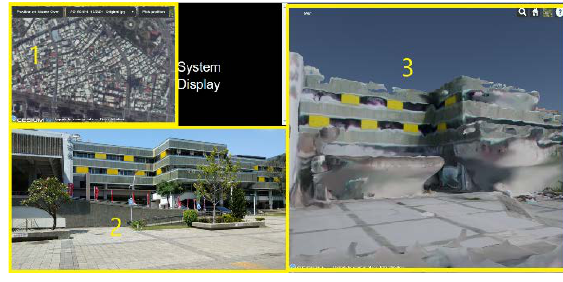
Figure 11. Synchronized dual-window system